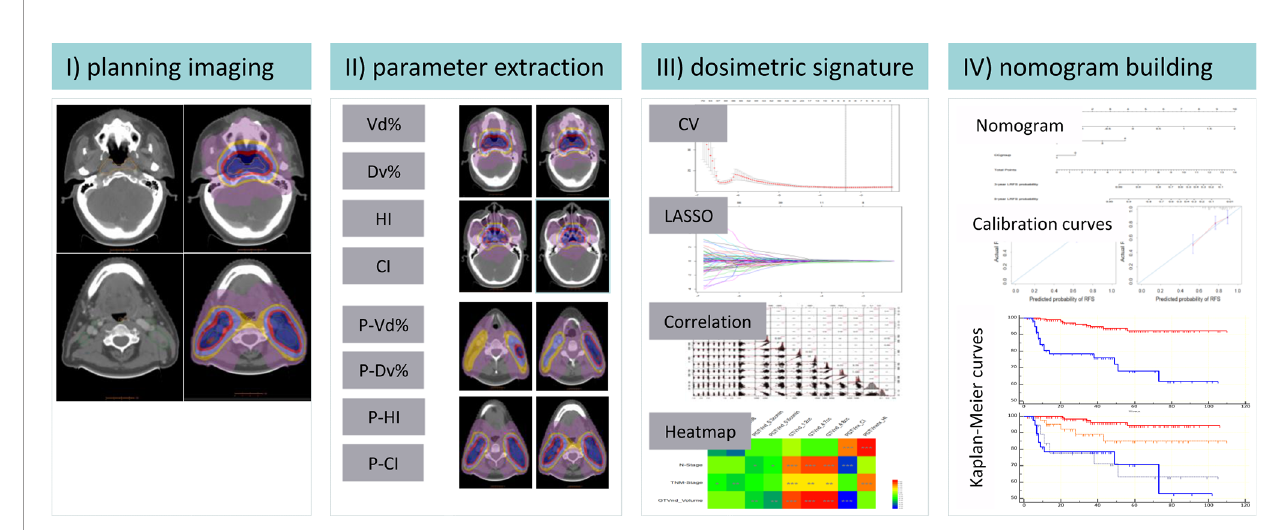
FIGURE 1 | Schematic diagram of the proposed nomogram. CI, conformal index; HI, homogeneity index; Vd%, the volume exposed in d Gy; Dv%, the minimal dose delivered into v% of the volume; P-, the planning target volume; CV, cross-validation; LASSO, least absolute shrinkage and selection operator; GTVnx, nasopharynx gross tumor volume; GTVnd, lymph node gross tumor volume *P ≤ 0.05, **P ≤ 0.01, ***P ≤